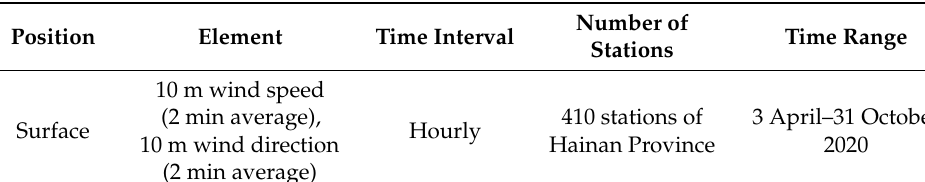
Table 1. Information on surface meteorological observation data.